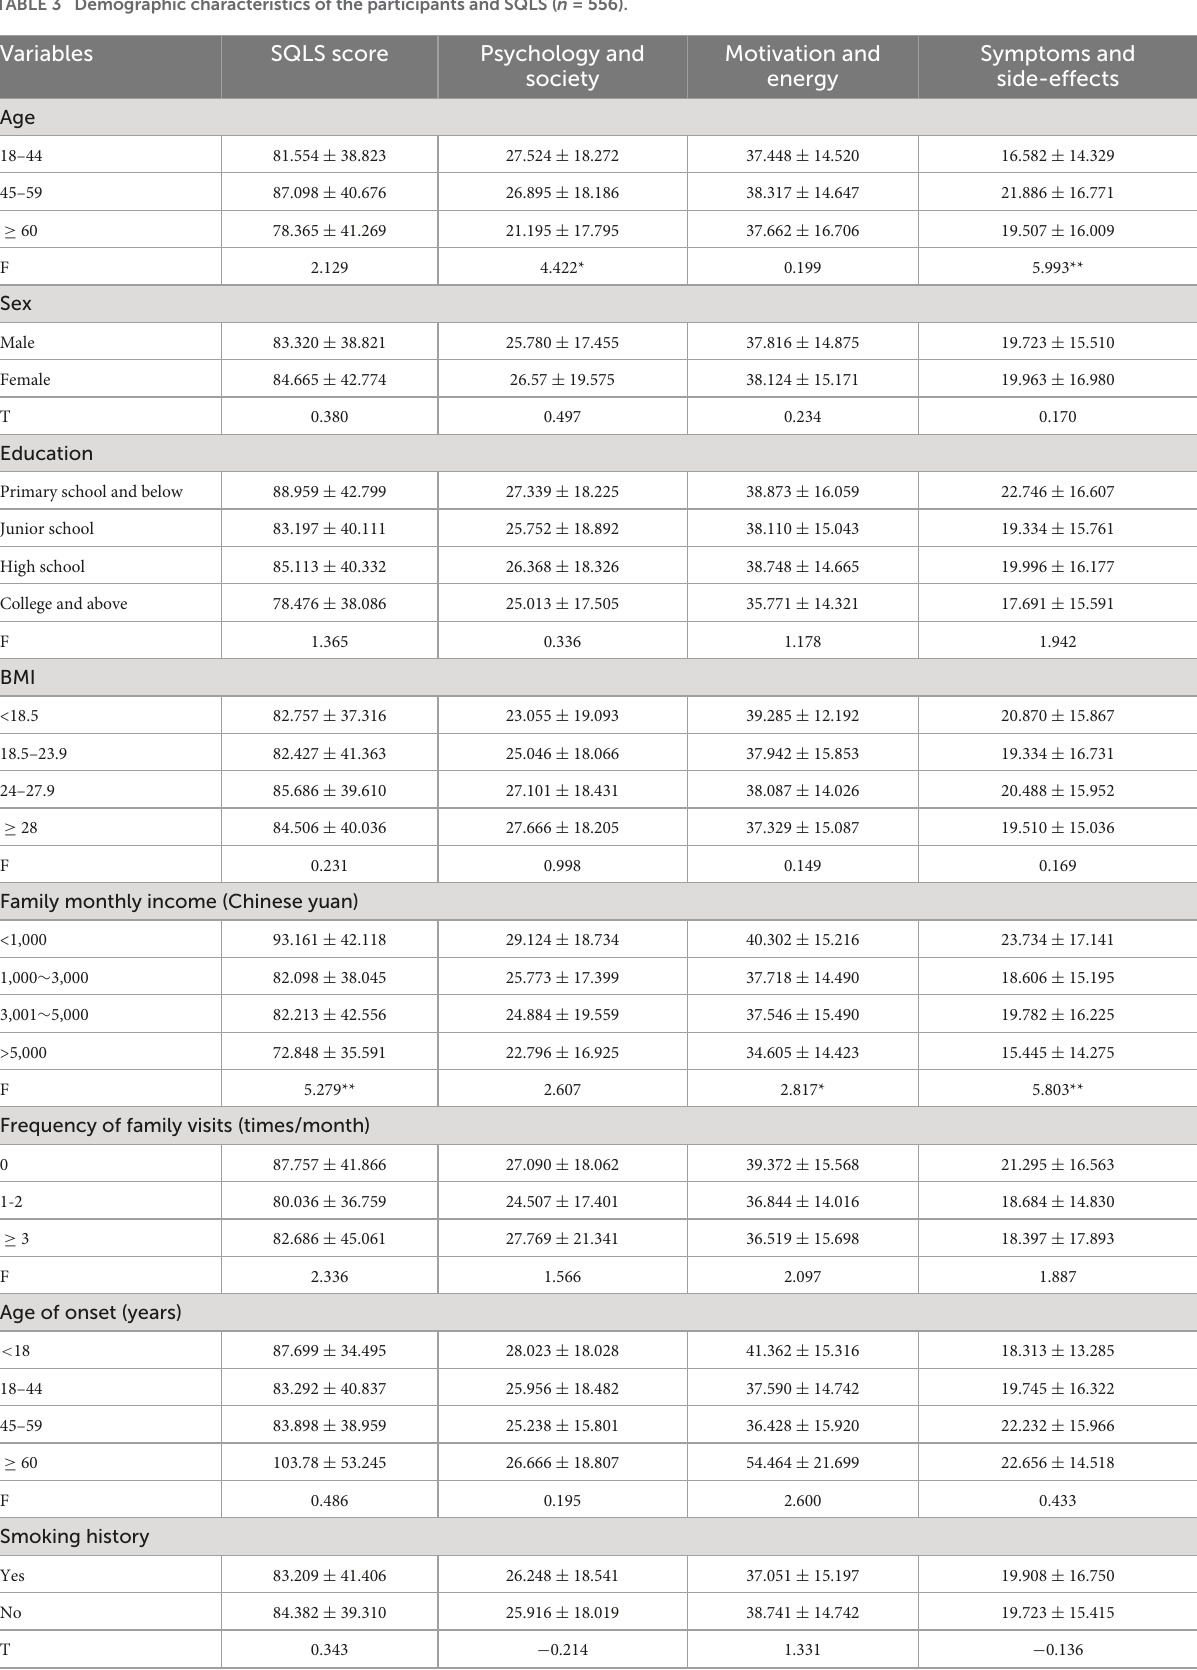
TABLE 3 Demographic characteristics of the participants and SQLS ( n =